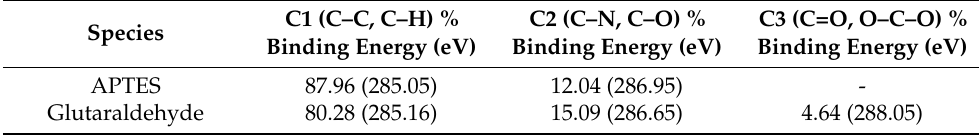
Table 1. C1s spectra of Si surface modified with APTES and glutaraldehyde.